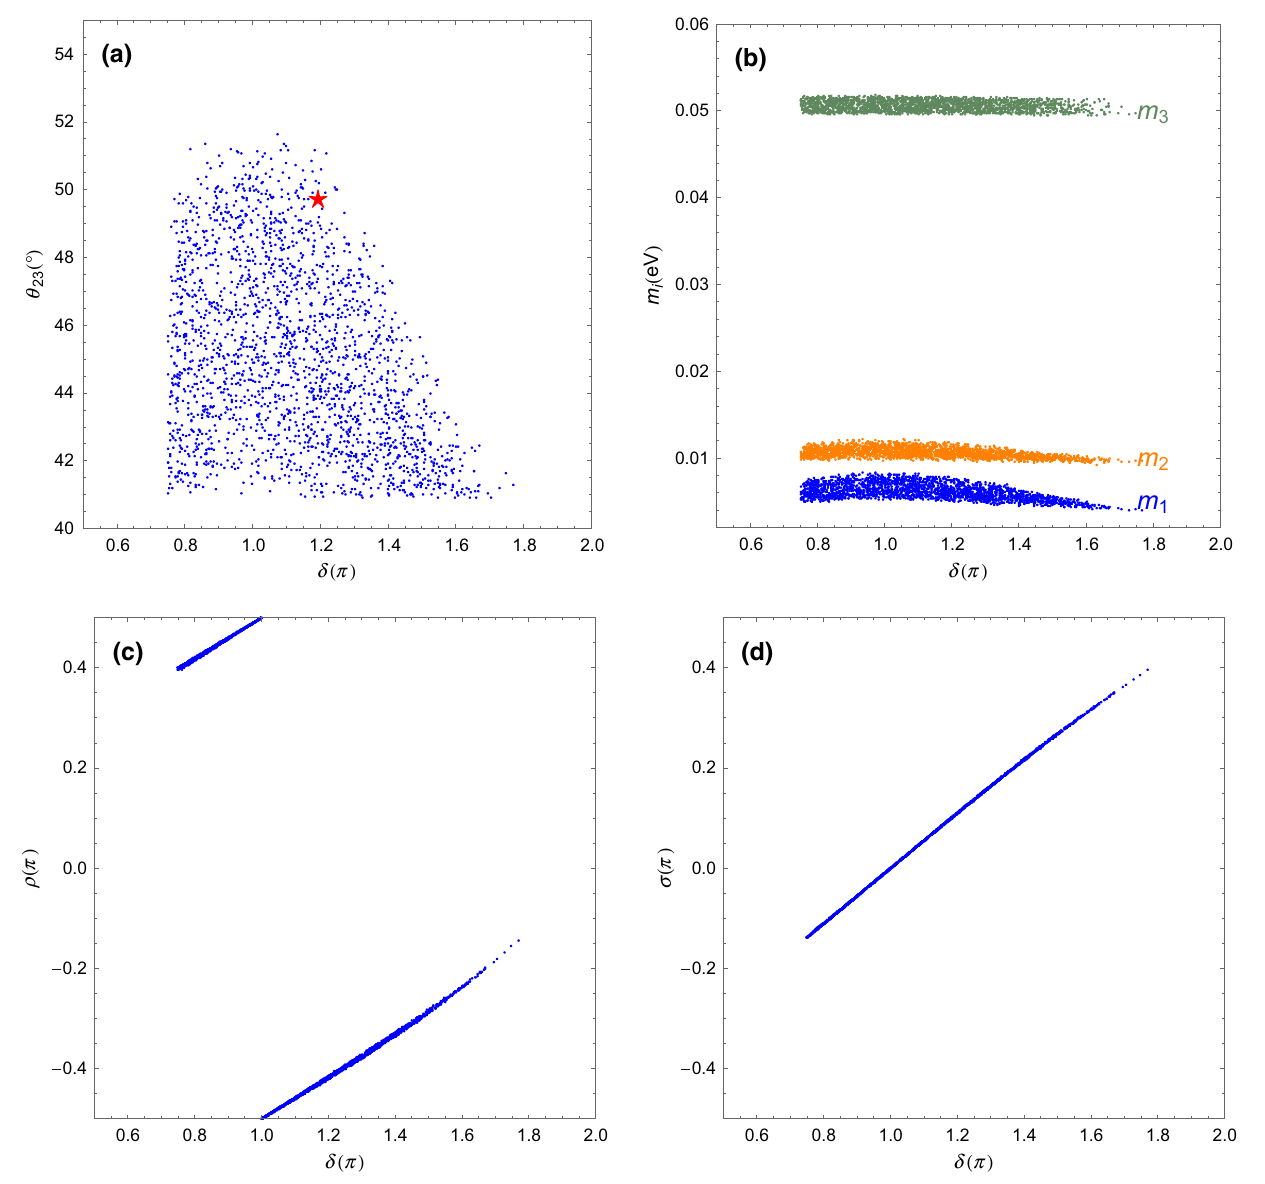
Fig. 2 Allowed samples of A 1 texture with neutrino oscillation data varied in 3 σ range of Ref. [49]. In pattern a , the red star stands for the best fit point from global